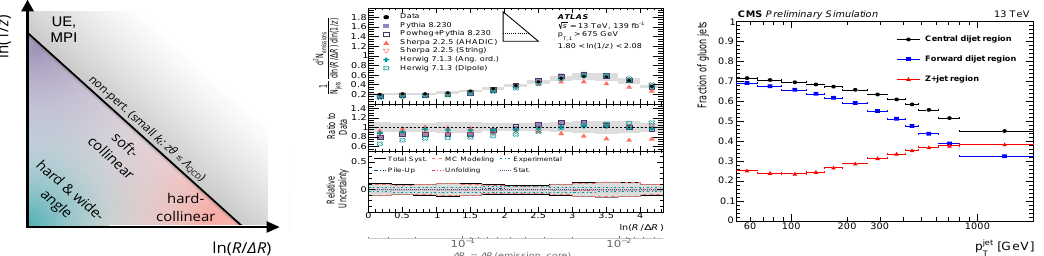
Figure 1: Schematic representation of the LJP (left). Unfolded LJP for 1.80 < ln(1 / z) < 2.08 (middle) [ 3 ] . Fraction of AK4 gluon jets in the Z + jet region, and the central and forward jets in the dijet region (right) [ 4 ]